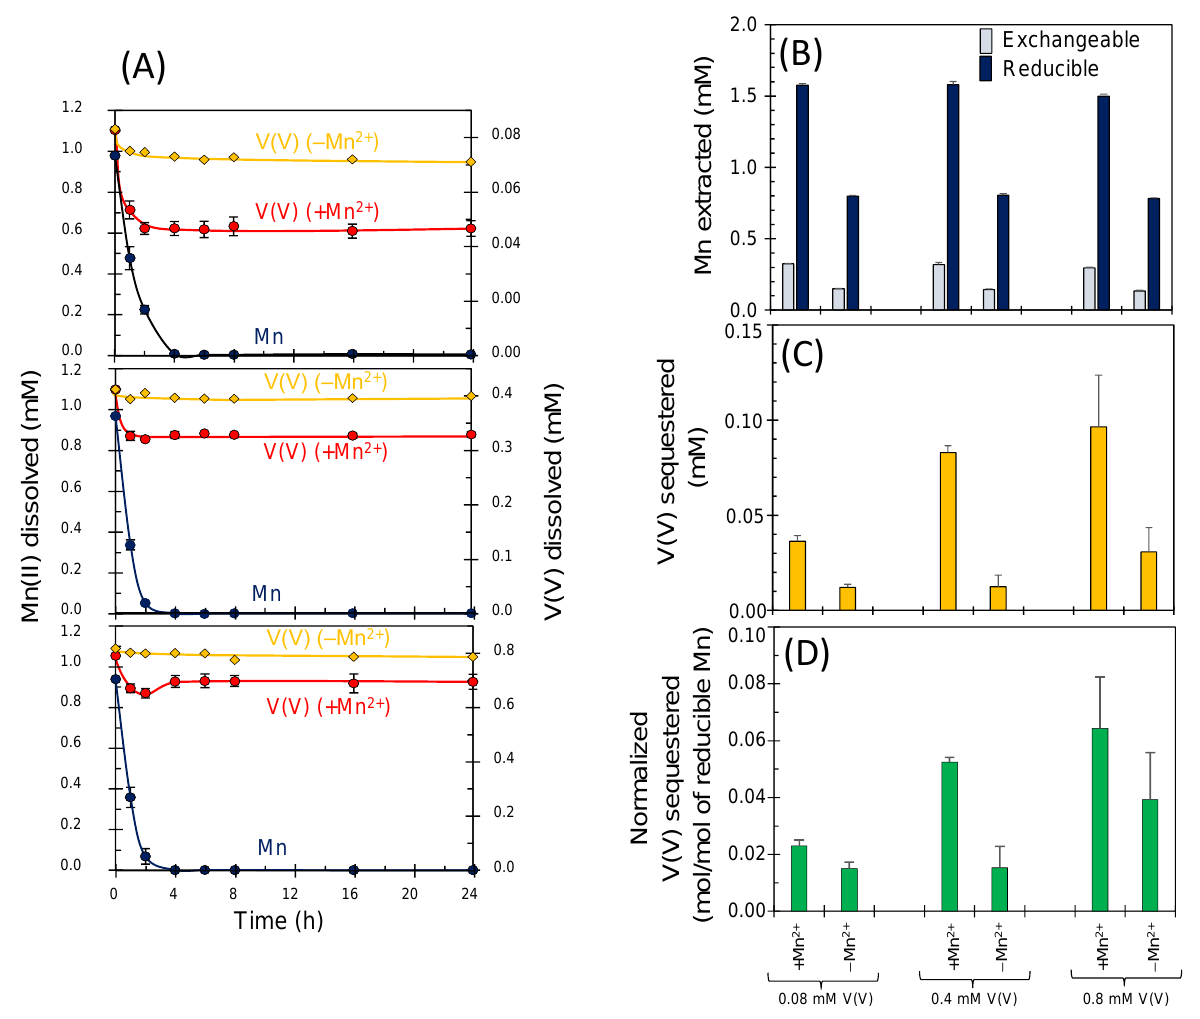
Figure 3. ( A ) Sequestration of V(V) (0.08 – 0.8 mM) by newly formed primary BMO (~1 mM as Mn) with and without exogenous Mn 2+ . Exogenous Mn 2+ was readily oxidized within 4 h of the reaction. ( B ) Two-step extraction for the resultant solid phases at 24 h of the reaction. ( C ) The concentration of V(V) sequestered (mM) and ( D ) the amounts of V(V) sequestered normalized to reducible Mn (mol/mol) with and without exogenous Mn 2+ at 24 h of the reaction. The error bars represent the standard deviation (n = 3).